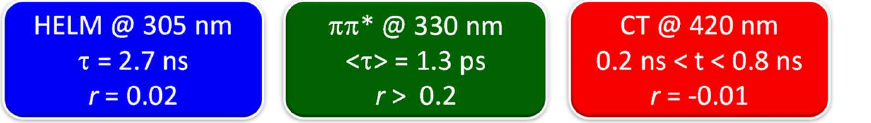
Figure 9. Limiting types of emitting states detected for A 20 • T 20 ; combined data from this work and reference [30].